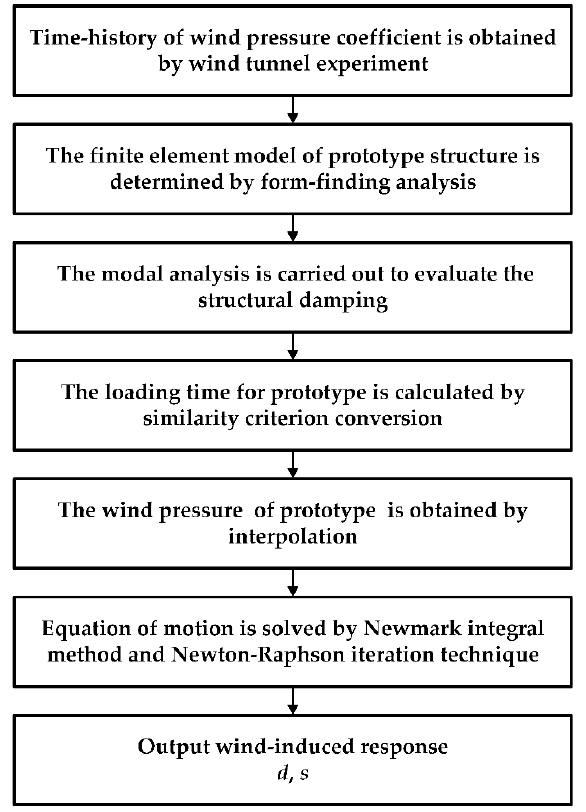
Figure 7. A flow chart of nonlinear dynamic time–history analysis.